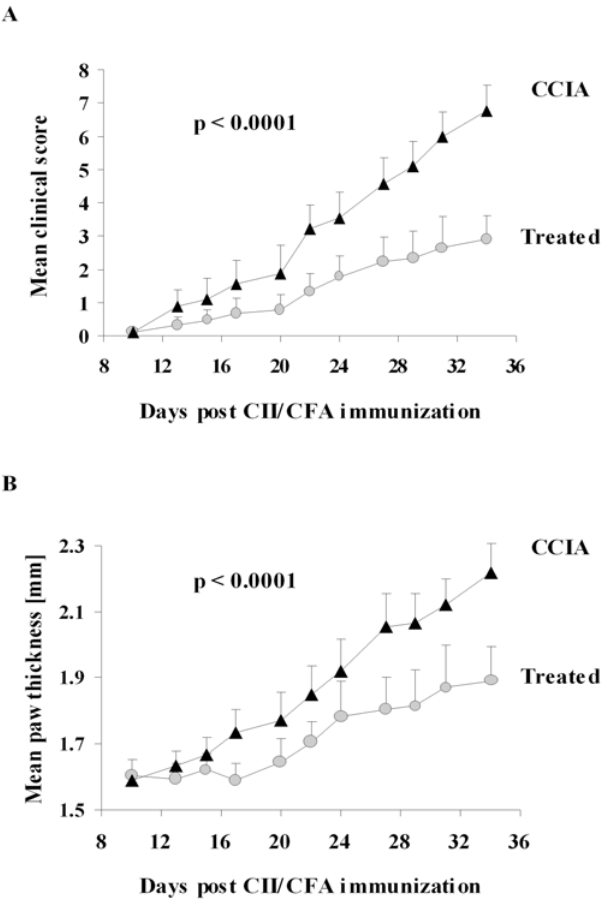
Figure 1. Epicutaneous immunization prevents evolution of arthritis. DBA/1-TCR- b Tg mice were epicutaneously immunized with CII 3 weeks prior to induction of disease by injection of CII in CFA. Mice were evaluated and clinical score (A) and hind paw thickness (B) were assessed every second day. Data represents the mean + 1 SEM (n=9). The epicutaneous immunization had a highly significant effect on disease severity as analysed by two-way ANOVA. The entire in vivo experiment was repeated twice with very similar results. ( $ )=treated with epicutaneous CII, ( m )=sham-treated CCIA controls.